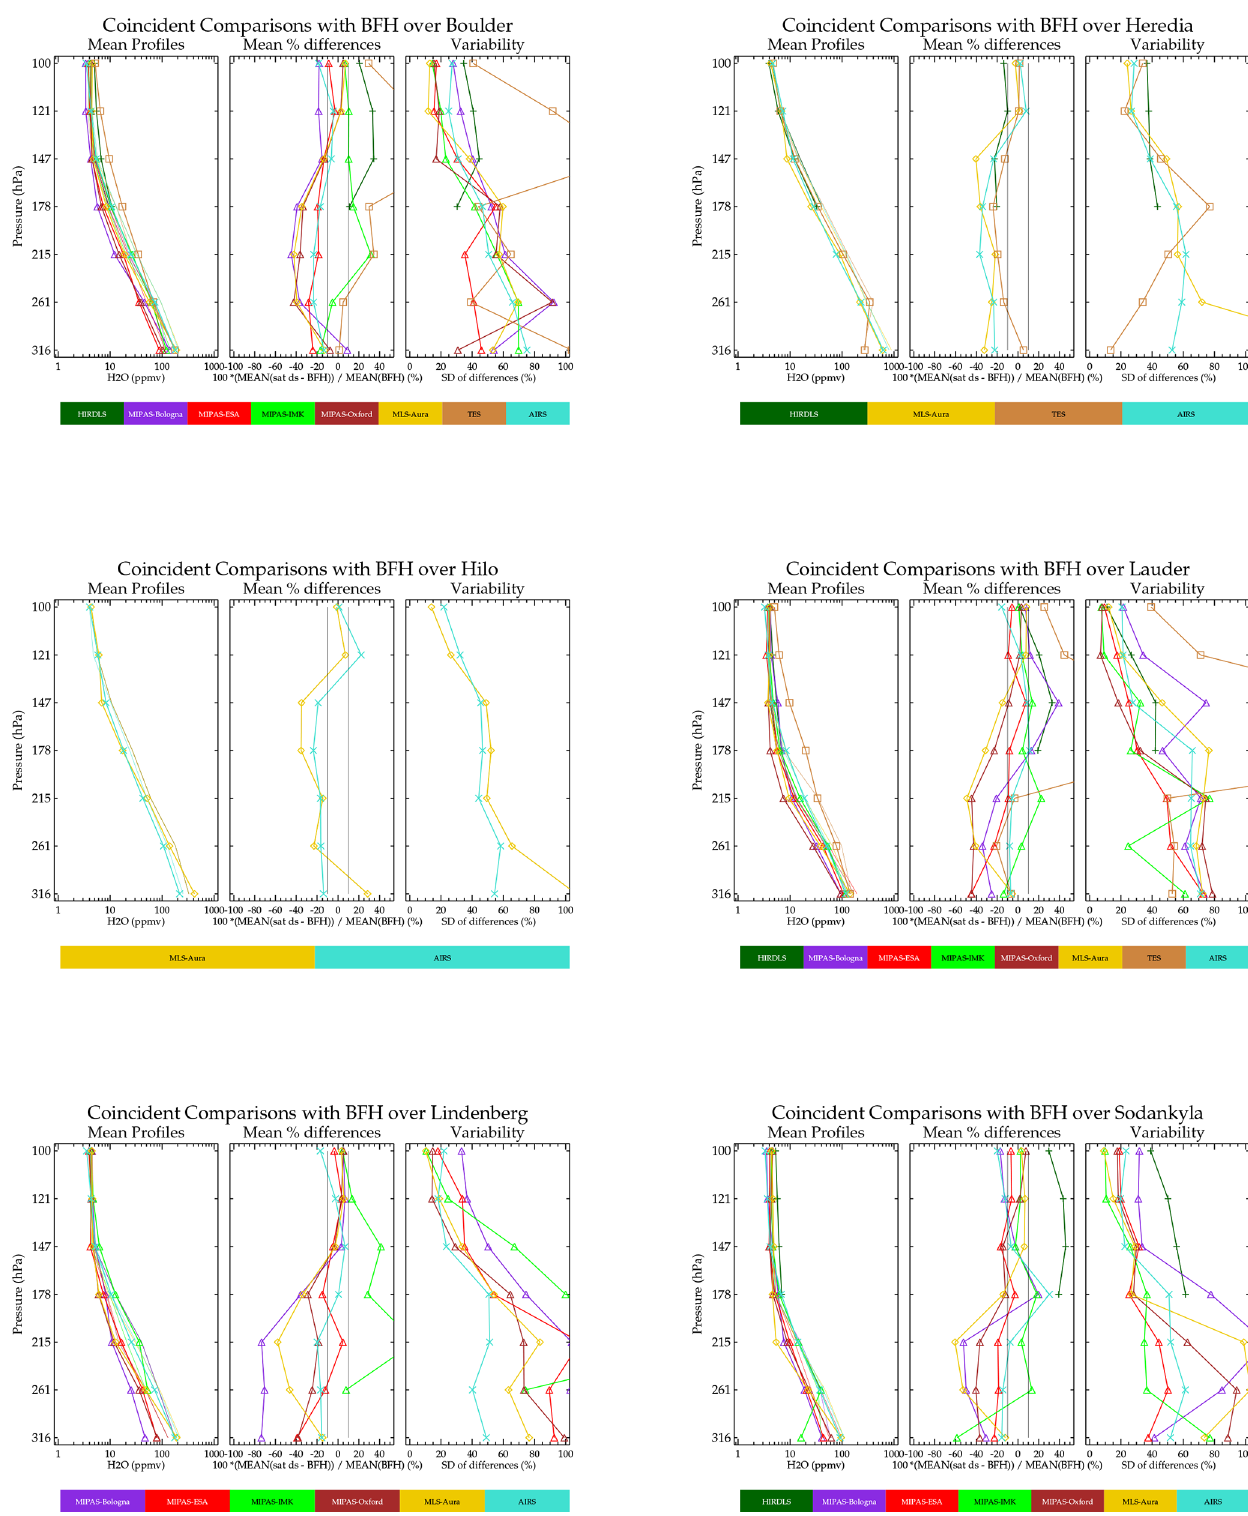
Figure 6. Same as Fig. 5 but for different BFH locations. No averaging kernel was